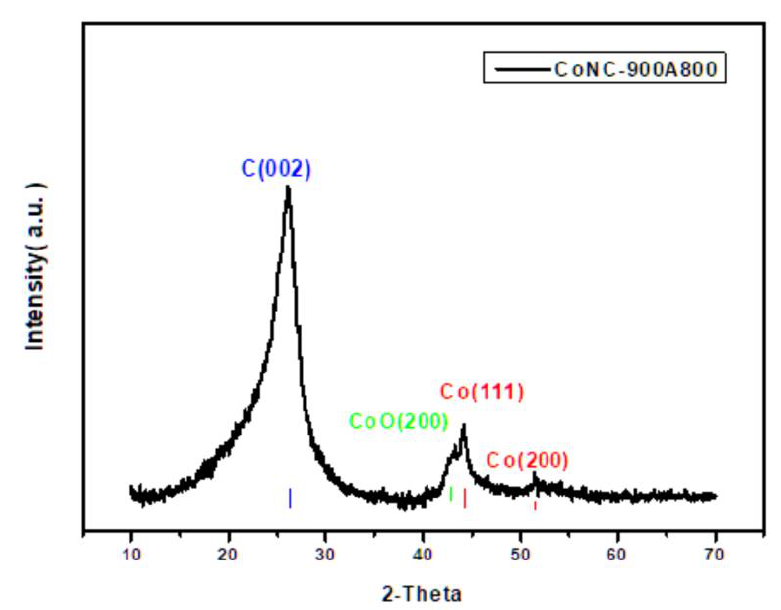
Figure 4. X-ray diffraction pattern of CoNC-900A800.